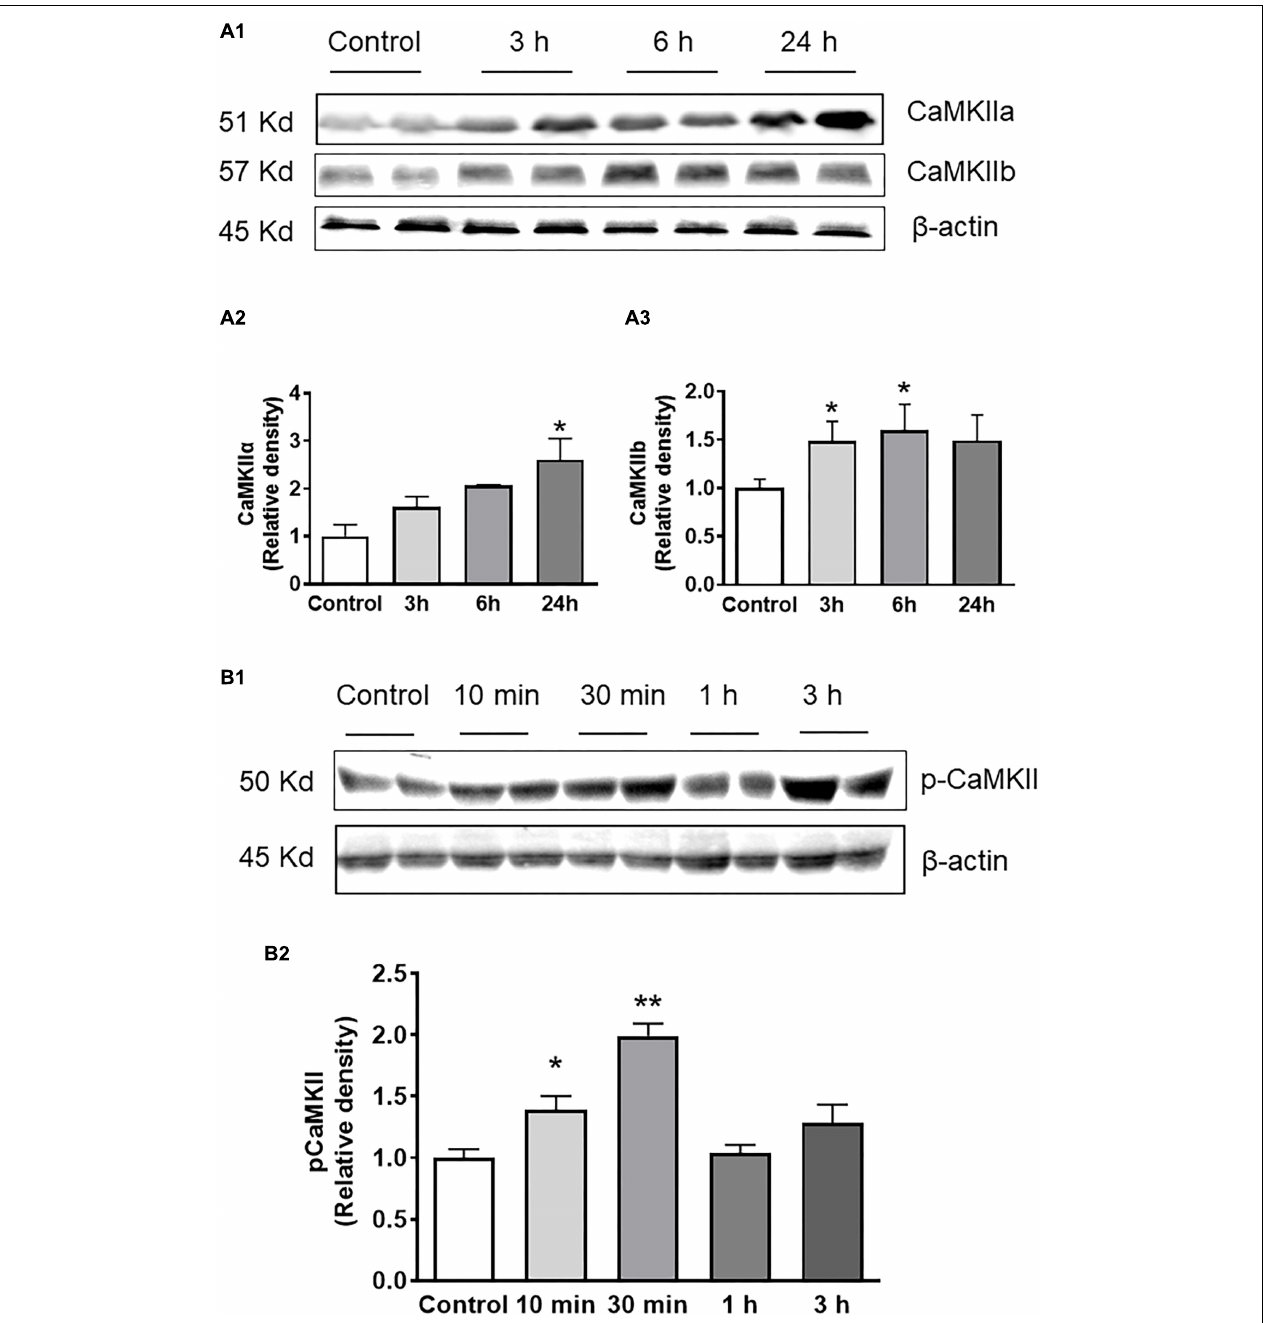
FIGURE 4 | Orexin-A treatment increases CaMKII subunits’ protein expression as well as CaMKII activation in PC12-OX1R cells. PC12-OX1R cells were incubated with 100 nM orexin-A for the indicated periods. Proteins were separated and probed with CaMKIIa, CaMKIIb, P-CamKII, and β -actin antibodies. (A) Orexin-A treatment increases CaMKII protein expression in a time-dependent manner. (A1) Representative western blots showing CaMKIIa, CaMKIIb, and β -actin in orexin-A treated and control cells. Quantification of CaMKIIa (A2) and CaMKIIb (A3) that has been normalized against β -actin and compared with control, normalized to unity ( n = 6, * P < 0.05). (B) Orexin-A treatment results in a time-dependent increase in P-CaMKII level. (B1) representative western blots showing P-CaMKII and β -actin. (B2) Quantification of P-CaMKII that has been normalized against β -actin and compared with control, normalized to unity ( n = 6, * P < 0.05, ** P <